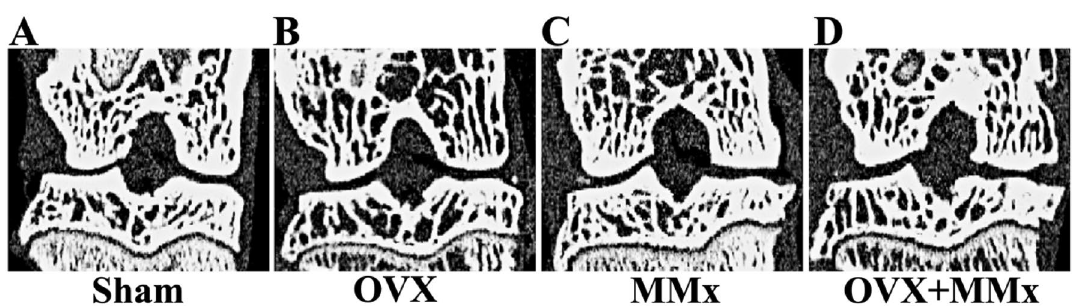
Figure 4. Microcomputed tomography images and bone mineral densities of knee joints ( A, B, C, D ). Osteoporotic changes were observed in the OVX rats ( B ). Subchondral sclerosis and osteophyte formation within the medial compartment were observed in the MMx and OVX + MMx rats ( C, D ). Sham OVX MMx OVX +